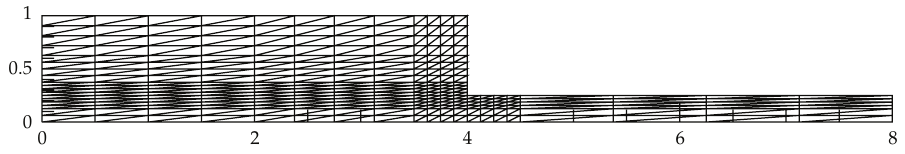
Figure 1: Plot of 4 : 1 contraction domain geometry and sample mesh.